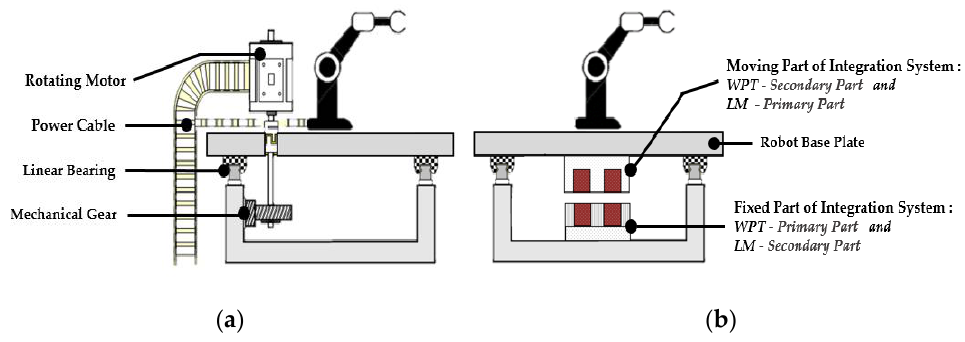
Figure 1. Transfer system. ( a ) Conventional system. ( b ) Proposed system.